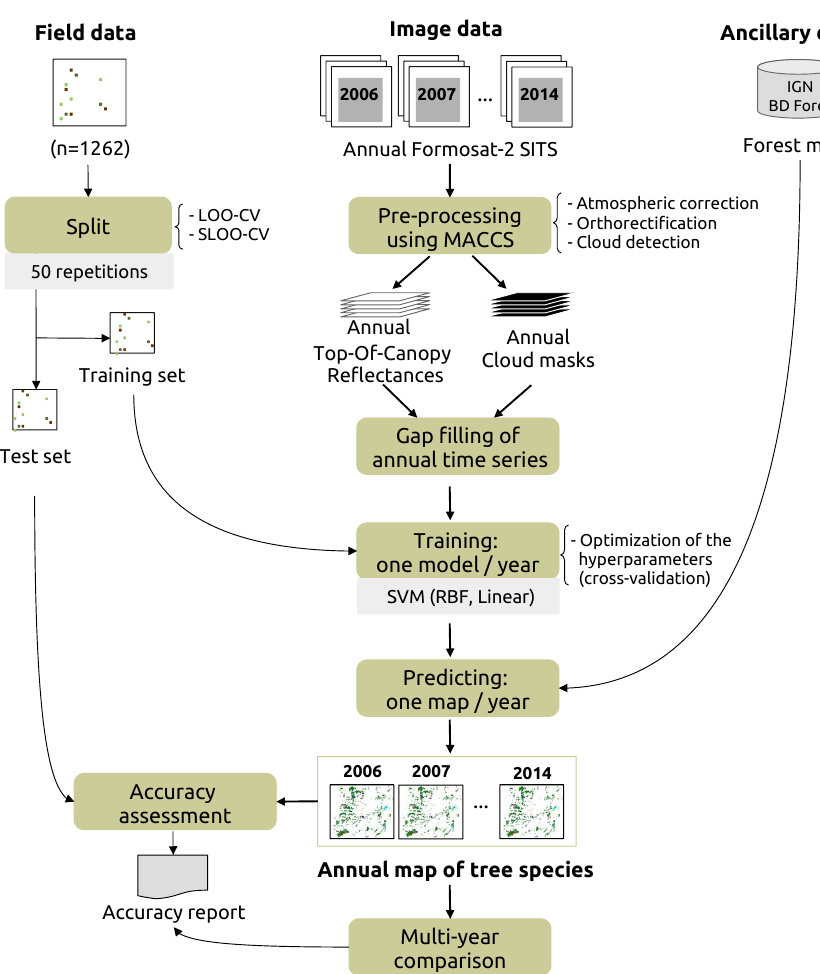
Figure 3. Classification protocol for a single year time series, repeated for the 9 years available from 2006 to 2014. The splitting procedure to create independent training and test sets is based on a spatial and non-spatial leave-one-out cross-validation (SLOO-CV and LOO-CV, respectively). The LOO-CV were trained with exactly the same number of training samples as the SLOO-CV, after random